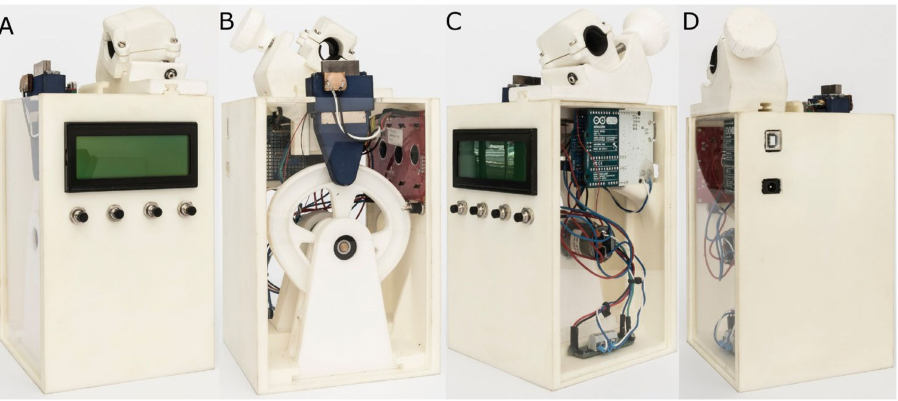
Figure 1. ( A ) Front, ( B ) back, ( C ) right side, and ( D ) left side of the dynamic cyclic fatigue device.